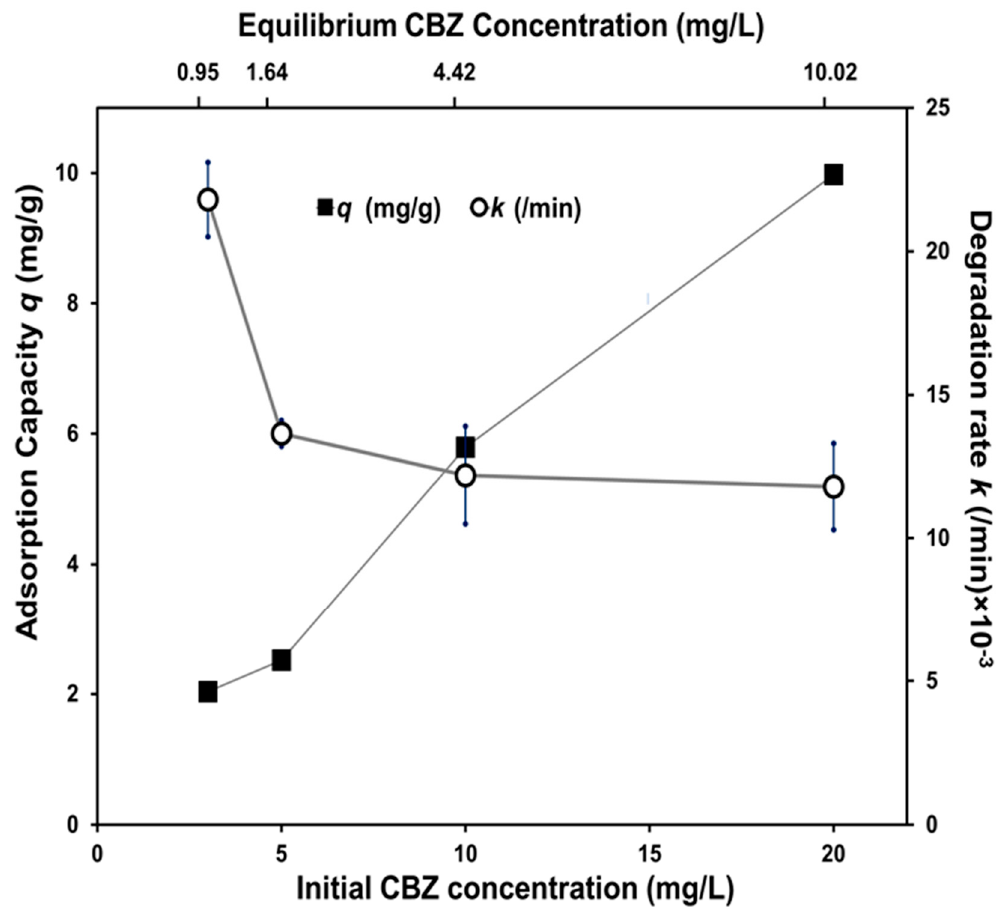
Figure 5. E ff ect of initial CBZ concentration on equilibrium adsorption q and degradation k Figure 5. Effect of initial CBZ concentration on equilibrium adsorption q and degradation k rate rate (experimental conditions: pH 7 ± 0.2; concentration of UiO-66_GO-0.5 = 1 g / L; solution (experimental conditions: pH 7±0.2; concentration of UiO-66_GO-0.5 = 1 g/L; solution volume V = 50 volume V = 50 mL). Plots and error bars represent the averages and standard deviations from mL). Plots and error bars represent the averages and standard deviations from duplicate experiments. duplicate